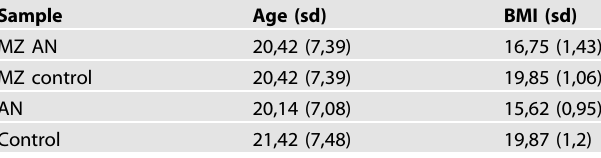
Table 1. Clinical characteristics of the samples from both cohorts, The twin sample was composed of 7 MZ twin pairs. The validating sample was composed of 7 matched controls by age and BMI, and 7 matched AN patients by age and BMI.